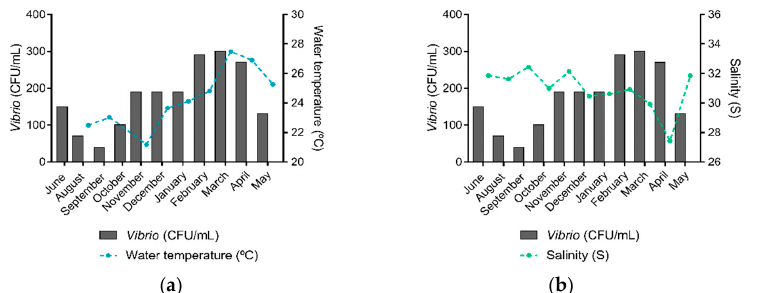
Figure 3. Water temperature, salinity, and Vibrio spp. abundance in the Guanabara Bay in each sampling expedition over the course of one year. ( a ) Average water temperature ( o C) and the total of Vibrio spp. (CFU/mL) identified and ( b ) Average salinity (S) levels and the total of Vibrio spp. (CFU/mL) identified in each sampling expedition. Overall, there was a moderate negative correlation on site 1 (bottom) between Vibrio spp. abundance and nitrogen levels (r = − 0.698, p = 0.017) and a strong negative correlation with water transparency (r = − 0.764, p = 0.006). On site 7 (subsurface), a moderate negative correlation between Vibrio spp. abundance and salinity (r = − 0.652, p = 0.030), chlorophyll (r = − 0.656, p = 0.028), thermotolerant coliforms (r = − 0.619, p = 0.042), and total coliforms (r = − 0.695, p = 0.018) was observed. Also, site 7 (bottom) displayed a moderate negative correlation among Vibrio spp. abundance, thermotolerant coliforms (r = − 0.645, p = 0.032), and E. coli (r = − 0.648, p = 0.031), while a strong negative correlation was observed for total coliforms (r = − 0.765, p = 0.006). No statistically significant correlations were identified between the environmental parameters and Vibrio spp. abundance on site 34 (Table S5).